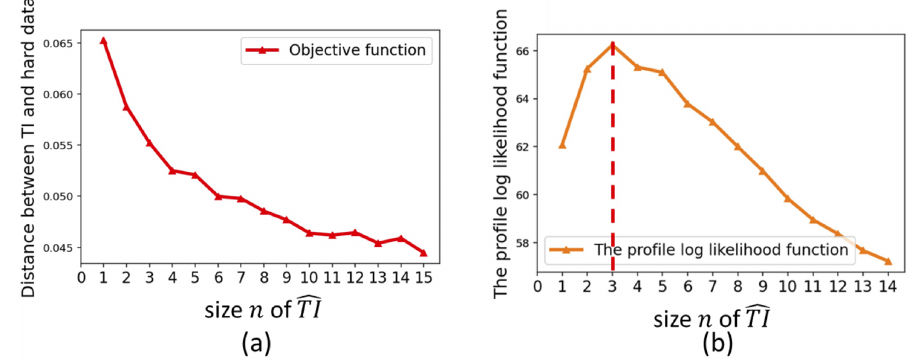
Figure A1. (a) PSO minimum distance vs. the swarm size n . (b) Profile log likelihood of the curve in panel (a) , suggesting the optimal number of training images is